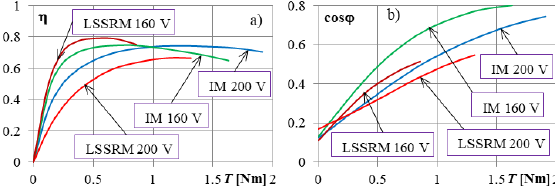
Fig. 7. Efficiency (a) and power factors (b) of IM and LSSRM for U = const